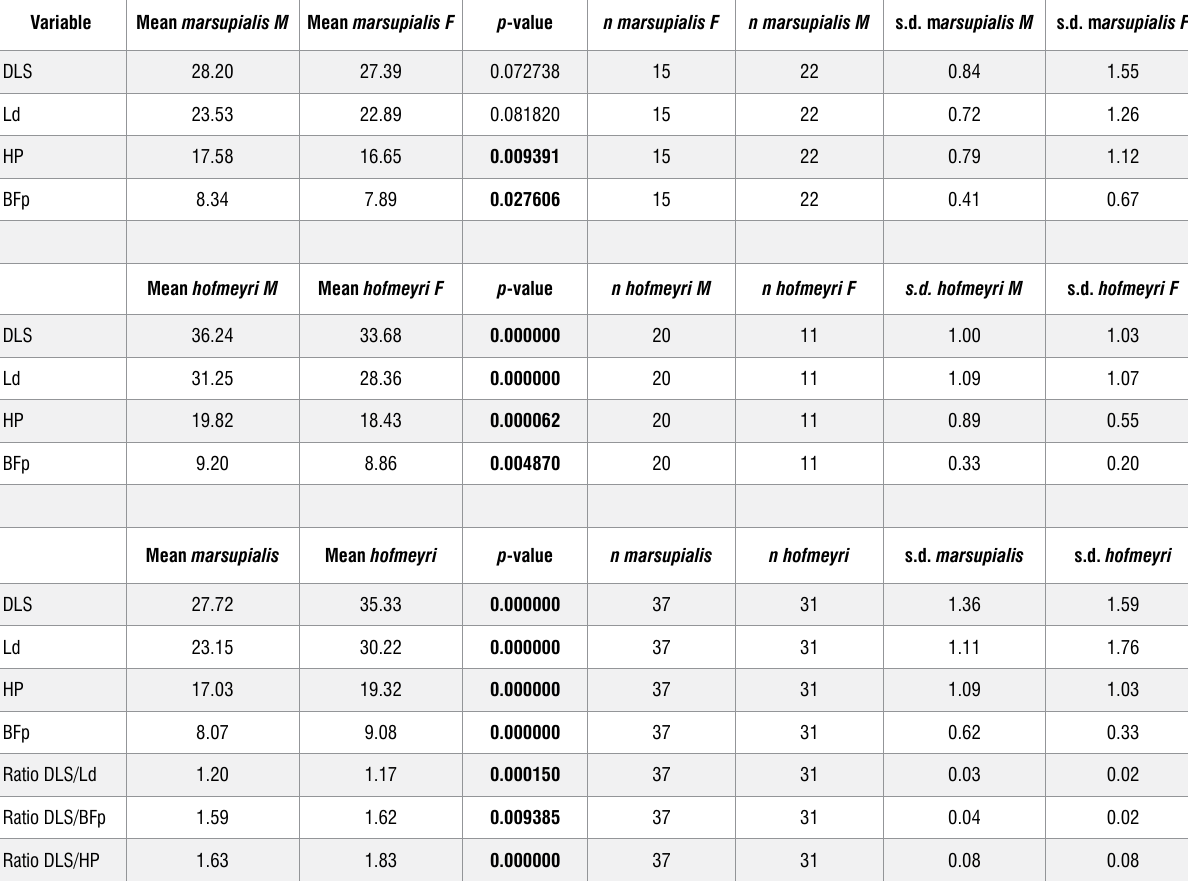
Table 1: Comparison of means between groups for sex-based and subspecies effects using t -tests Variable Mean marsupialis M Mean marsupialis F